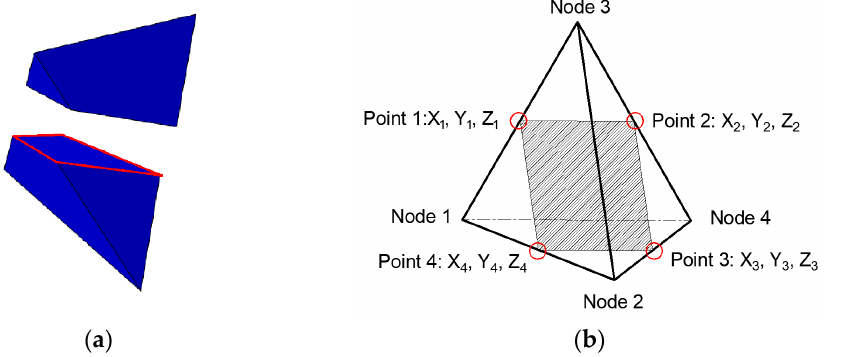
Figure 6. Crack length and width in a four-cornered crack segment: ( a ) fractured element; ( b ) intersection